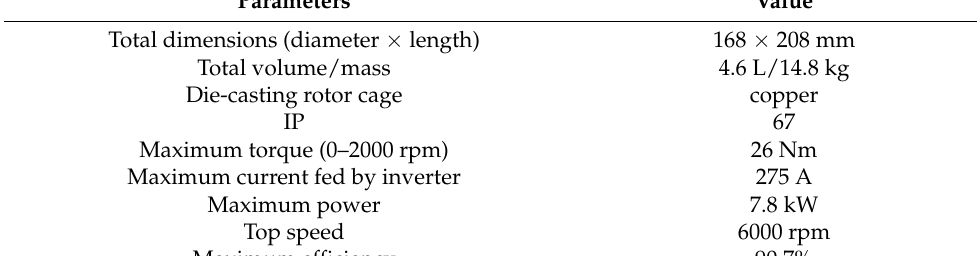
Table 1. E-engine design parameters and performances.